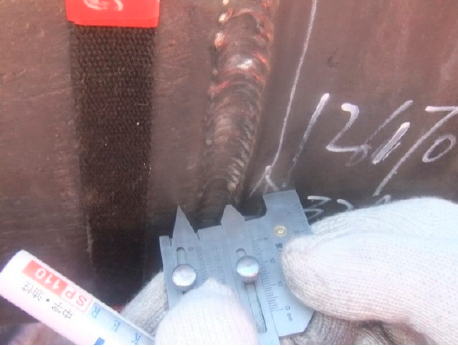
Figure 5. Profile of a mismatched weld joint.